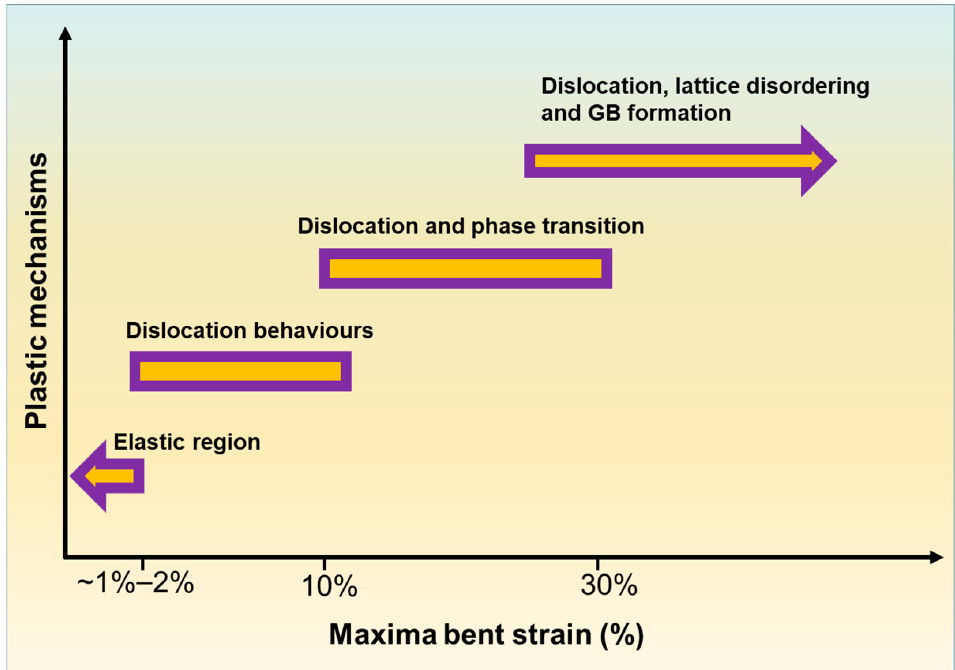
Figure 7. The NWs are first in the elastic strain region at the strain below ~1%. At the maximum bending strain below ~10%, plastic deformation is controlled by dislocation slips. At the bending strain of ~10–18.5%, phase transition occurs. At the bending strain above 18.5%, a GB is formed.